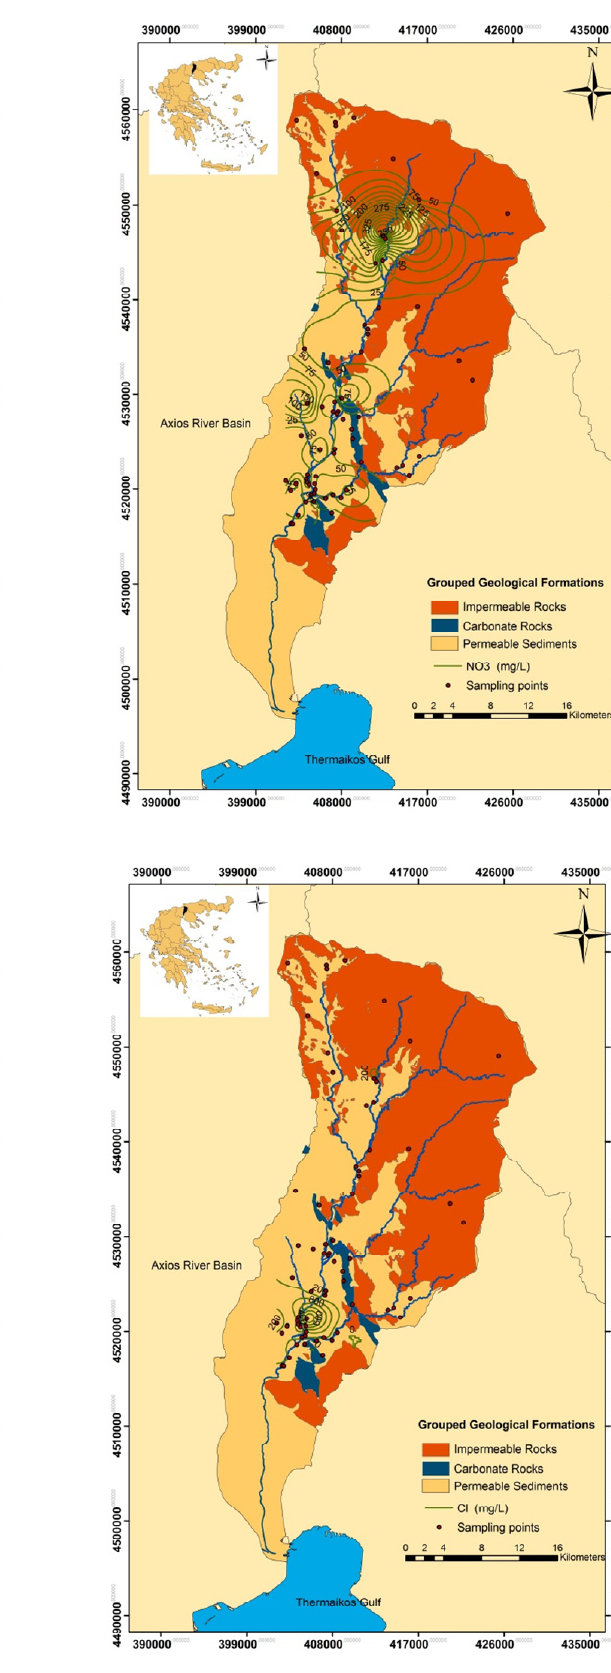
Figure 8. Spatial distribution of electrical conductivity, nitrates, sodium and chloride for the upper part of the Gallikos River